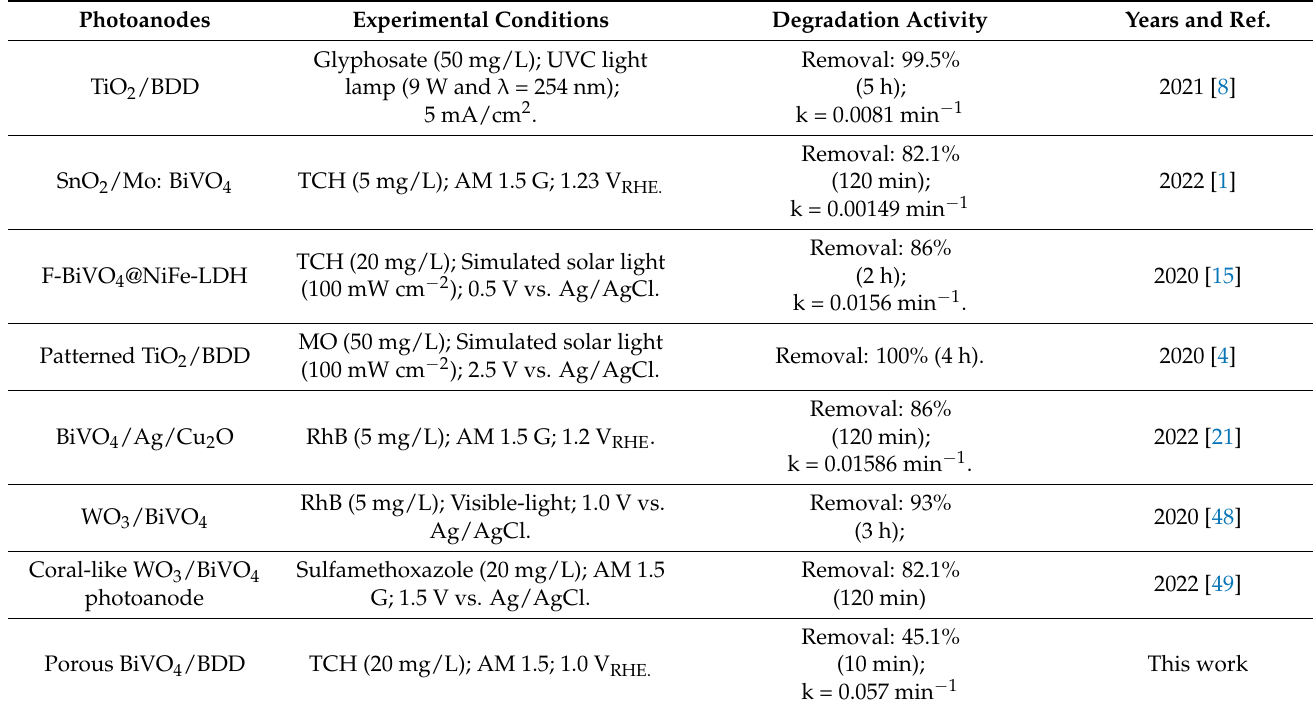
Table 1. Comparative PEC degradation results of BiVO 4 -based and BDD-based heterojunction pho- toanodes in recent years.